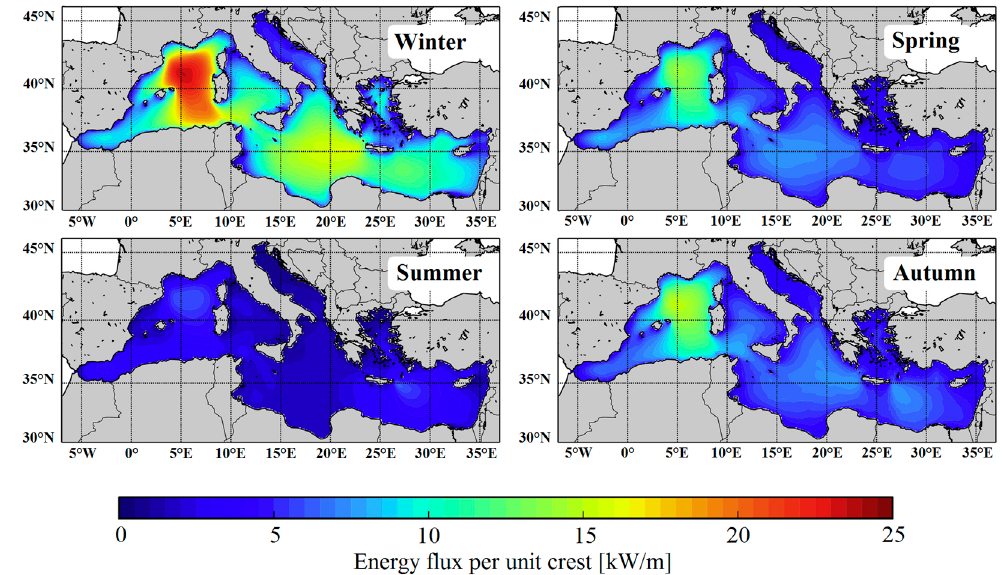
Figure 7. Average energy flux in the Mediterranean Sea, during seasons [25].